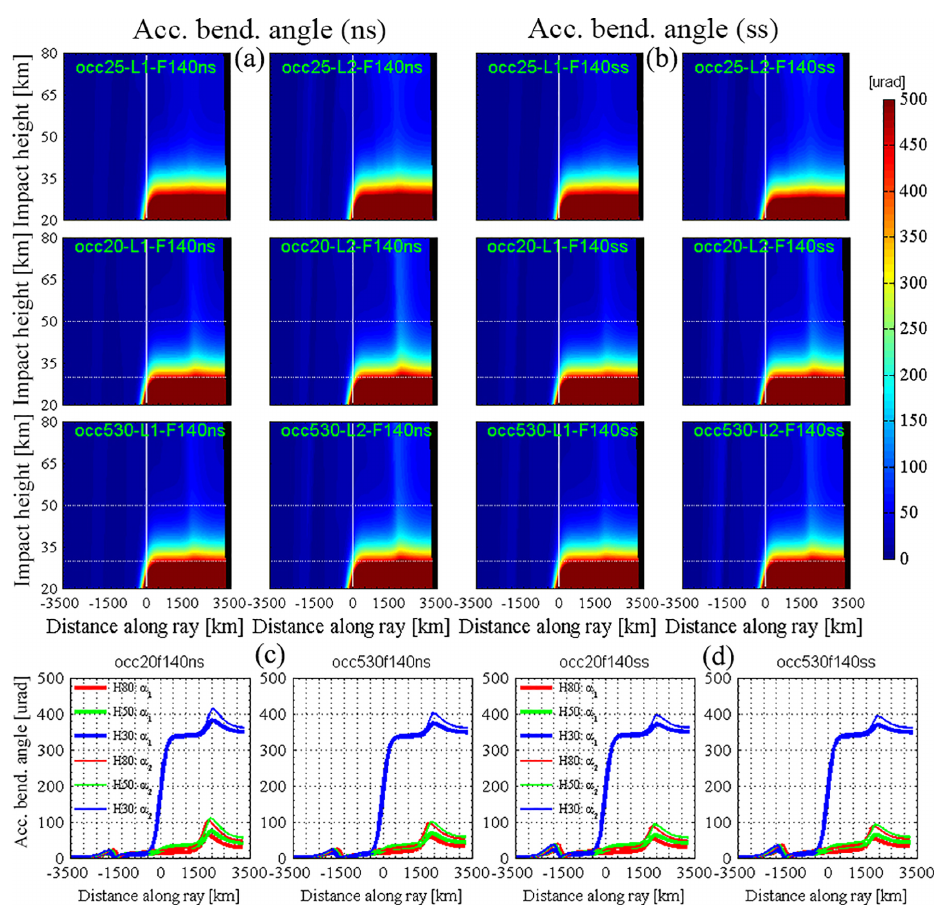
Figure 6. Images of the accumulated bending angle (Eq. 5) in the along-ray distance vs. impact height coordinate system for non-spherical- symmetry (a) and spherical symmetry (b) ionospheric conditions, and the corresponding along-ray behavior at three selected impact heights (c, d) . All panels are shown in the same format as for the delta impact parameter in Fig. 5 (see that caption for more details). Here the physical units are microradians